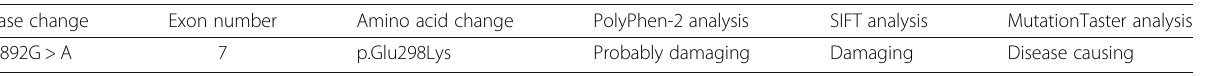
Table 1 Functional evaluation of the CLN6 mutations detected in the family of a Chinese boy with late infantile neuronal ceroid lipofuscinosis